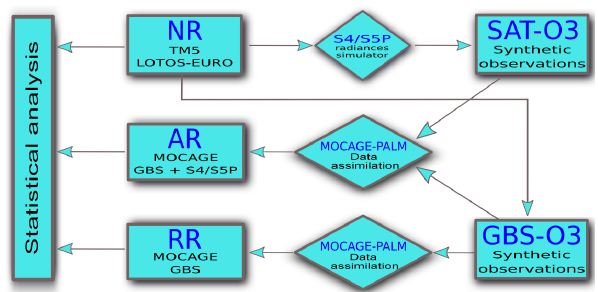
Figure 1. Diagram of the observing system simulation experiment (OSSE) components for ozone with the links between the different elements: the nature run (NR), the reference run (RR), the assimi- lation run (AR), and the observations, including ground-based sta- tion (GBS) measurements, and synthetic satellite observations from Sentinel-4 (S4) and Sentinel-5P (S5P)